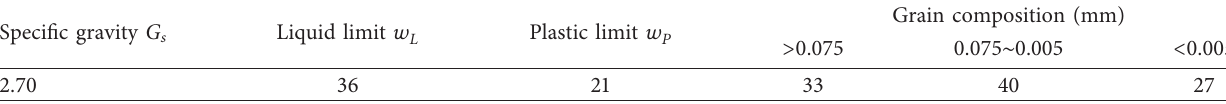
Table 2: Physical properties of dispersive soil.